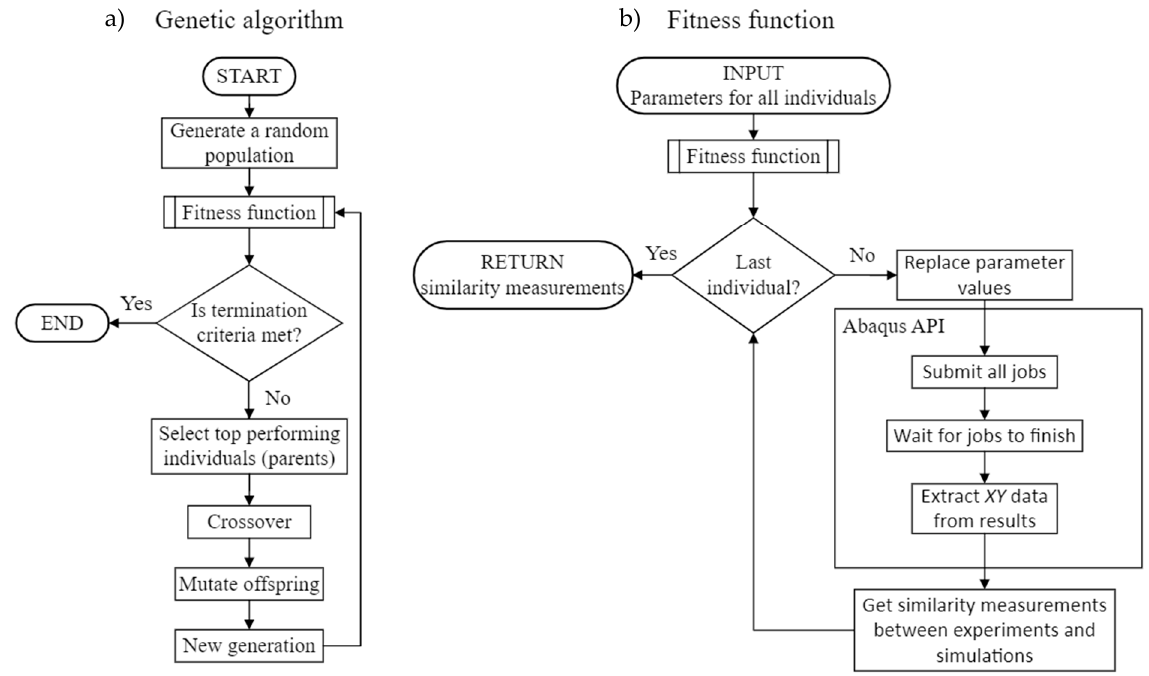
Figure 3. Optimization process flow diagram. GA ( a ) calculates the fitness score with a subprogram ( b ). The subprogram manages all Abaqus simulations and extracts results from them. Results are returned to the GA. Best performing individuals are selected as parents through crossover and mutation operations a new population is formed.